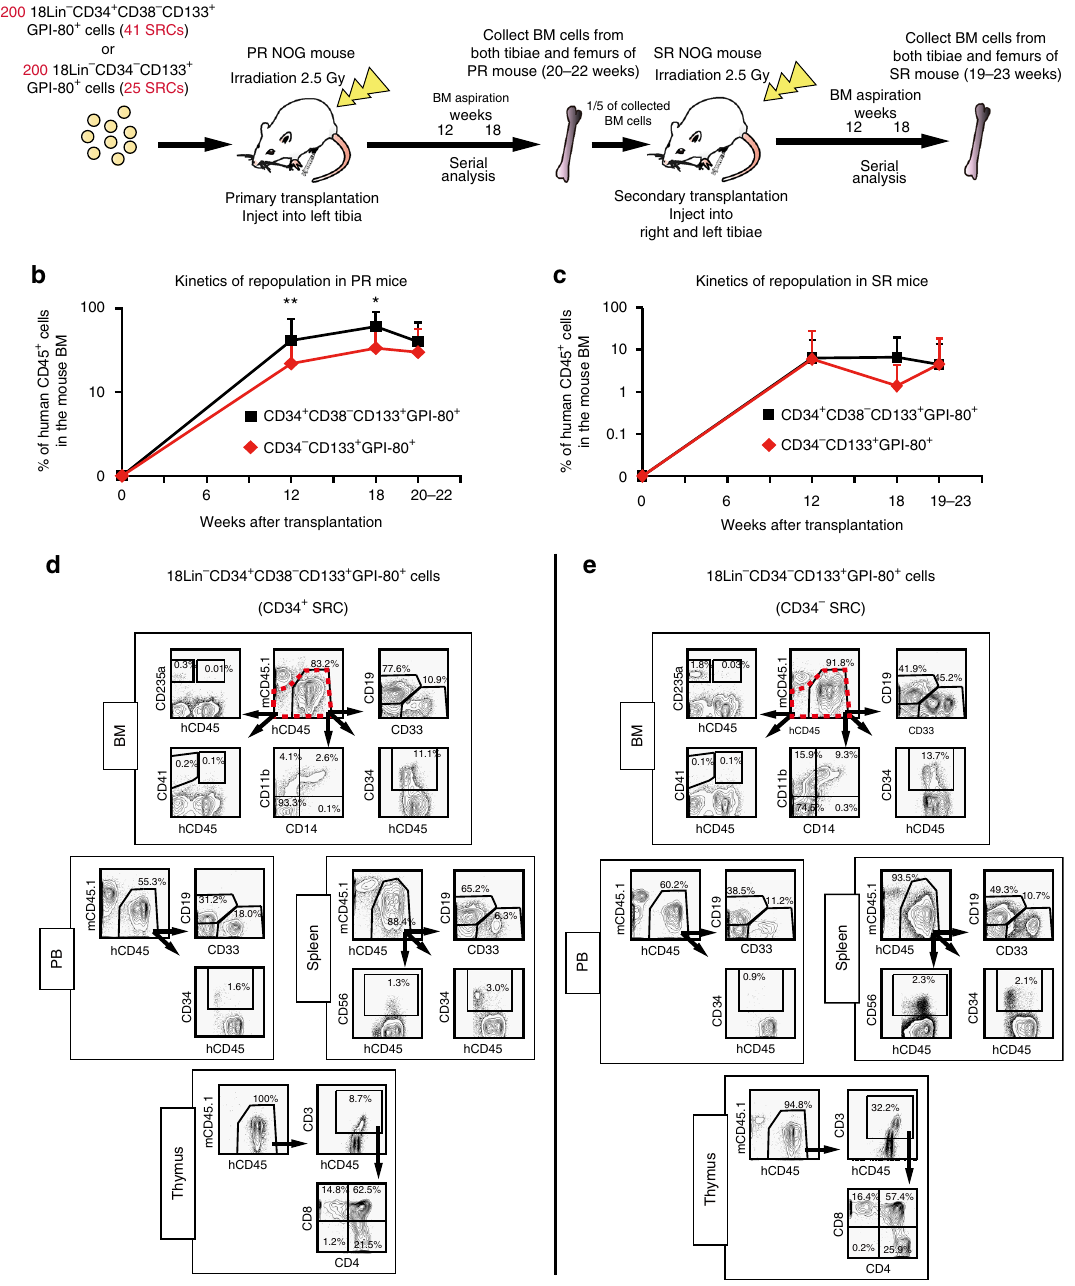
Fig. 2 SCID-repopulating cell activity and serial analyses of human cell repopulation of 18Lin − CD34 + CD38 − CD133 + GPI-80 + and 18Lin − CD34 − CD133 + GPI-80 + cells in primary and secondary NOG mice by IBMI. a A schematic illustration of primary and secondary transplantation of CD34 + and CD34 − SRCs is shown. PR, primary recipient; SR, secondary recipient. b The long-term repopulating potential of the CD34 + and CD34 − SRCs was determined by serially analyzing the kinetics of BM engraftment for 20 to 22 weeks in primary NOG mice that received transplants of 200 18Lin − CD34 + CD38 − CD133